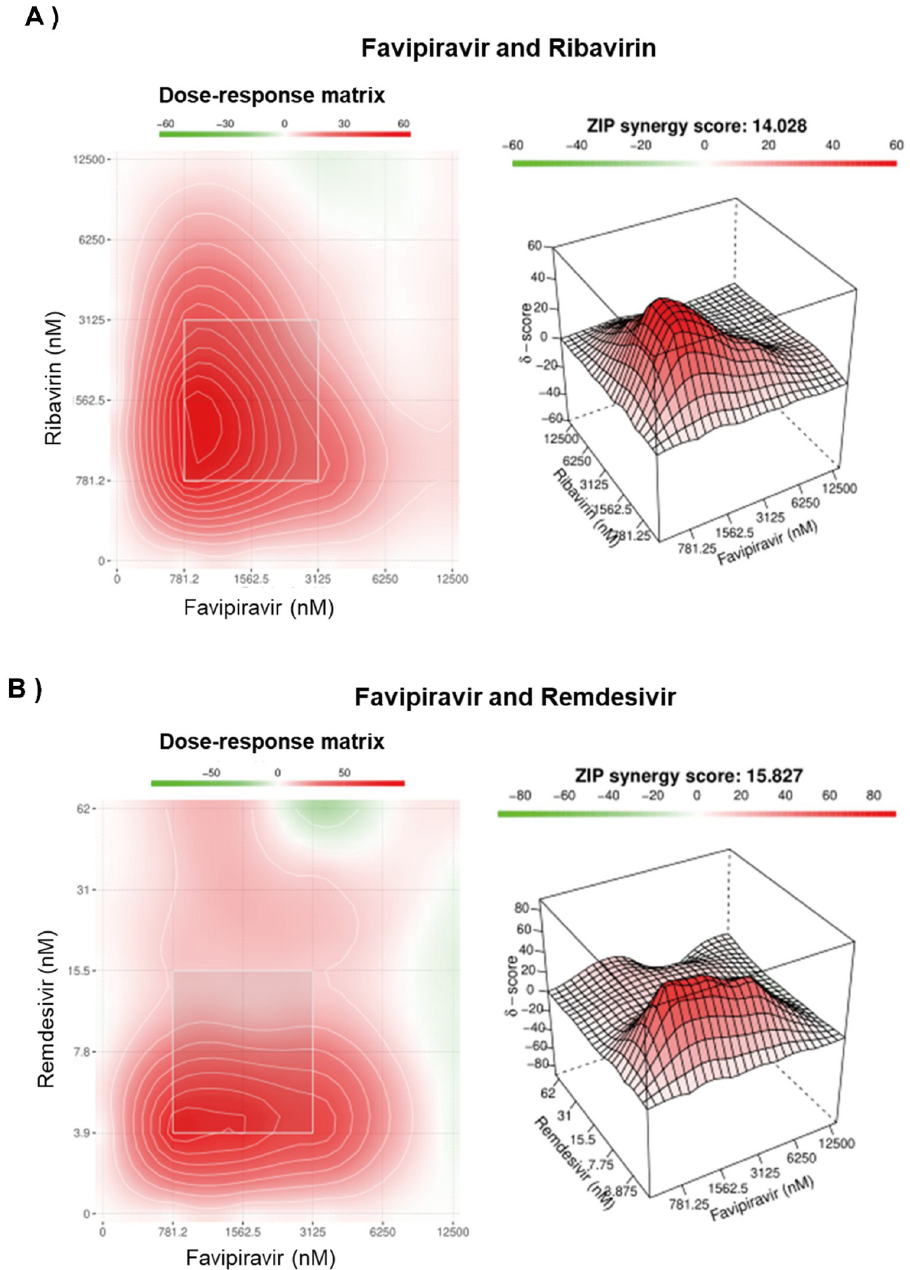
Fig 8. Combination inhibitory effect of favipiravir and ribavirin or remdesivir on JUNV. 293T were infected with JUNV (MOI: 0.1) and subsequently treated with a 6 × 6 drug combination matrix of favipiravir + ribavirin (A) or favipiravir + remdesivir (B) Dose-response matrix and synergy heat map are presented. Colored bar indicates the strength of synergy ( δ -score); less than − 10 is likely to be antagonistic, − 10 to 10 suggests an additive drug interaction, and larger than 10 indicates a synergistic effect. Data are means of two independent experiments in duplicates (n = 4). virus remained susceptible to higher concentrations of the drug, indicating that RdRp-D462 does not tolerate the chain termination activity of favipiravir, as was demonstrated in this study with the MG system (Fig 7D and 7F). Accordingly, the Candid #1-res virus remained